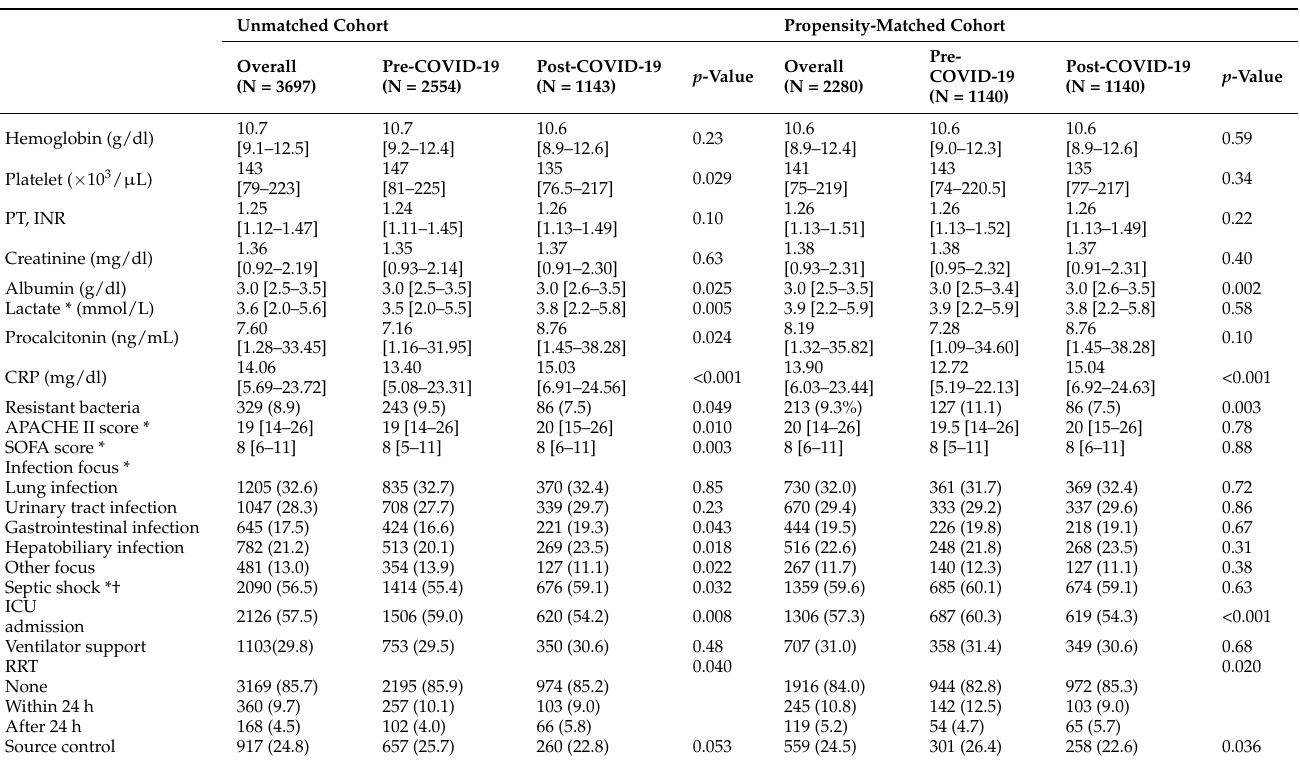
( n = 582/2280), and there was no significant difference between the pre- and post-COVID- 19 groups (25.4%, n = 290/1140 vs. 25.6%, n = 292/1140, respectively, p = 0.92). Both the